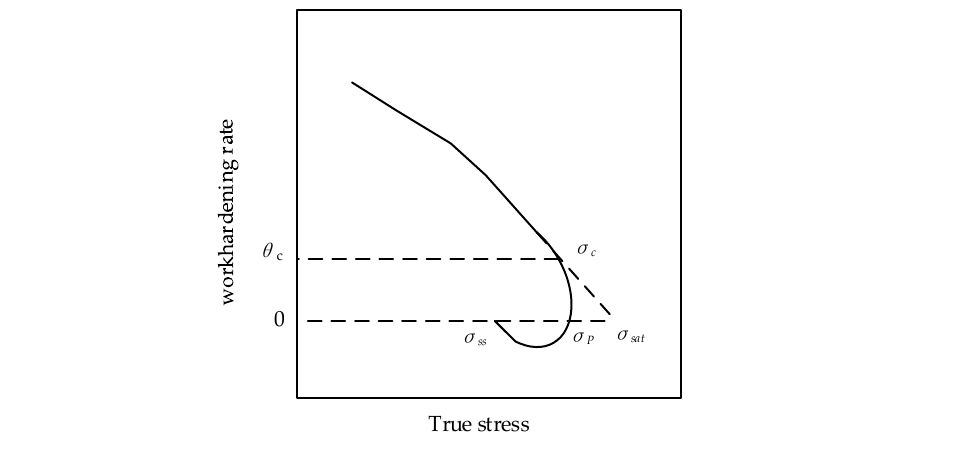
Figure 7. Typical relation curve of θ − σ .